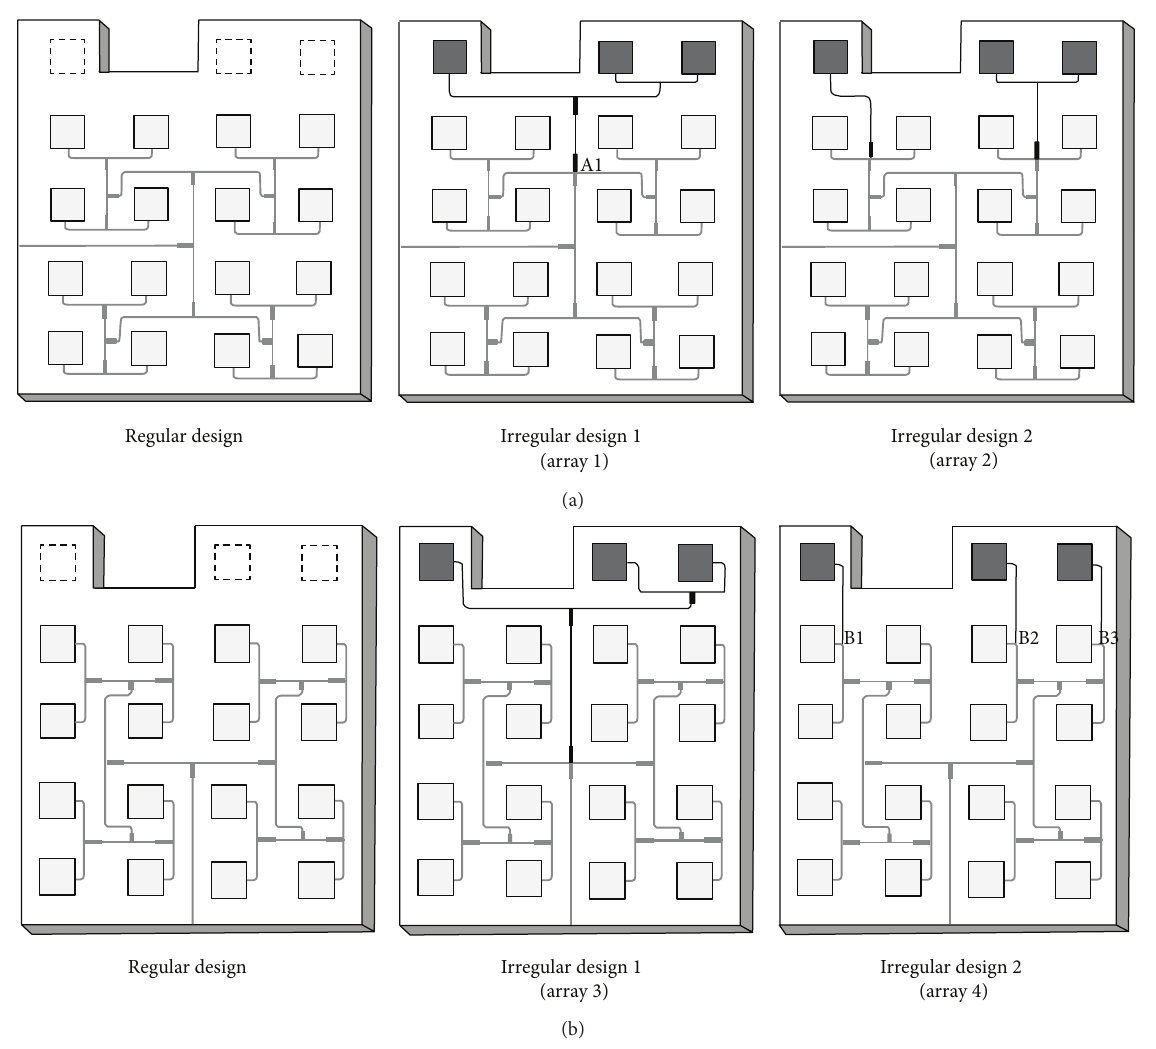
Figure 3: Designs of notched array (a) vertical and (b) horizontal